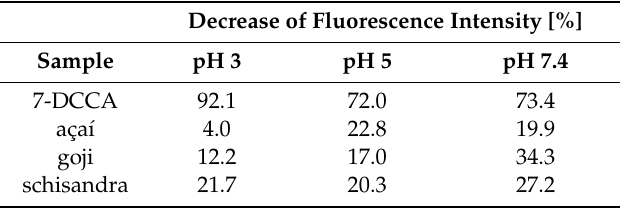
Table 1. The percentage drop in fluorescence intensity for all tested samples (4 mg / mL) under the influence of 360 µ M of NaOCl after 15 min of incubation at 25 ◦